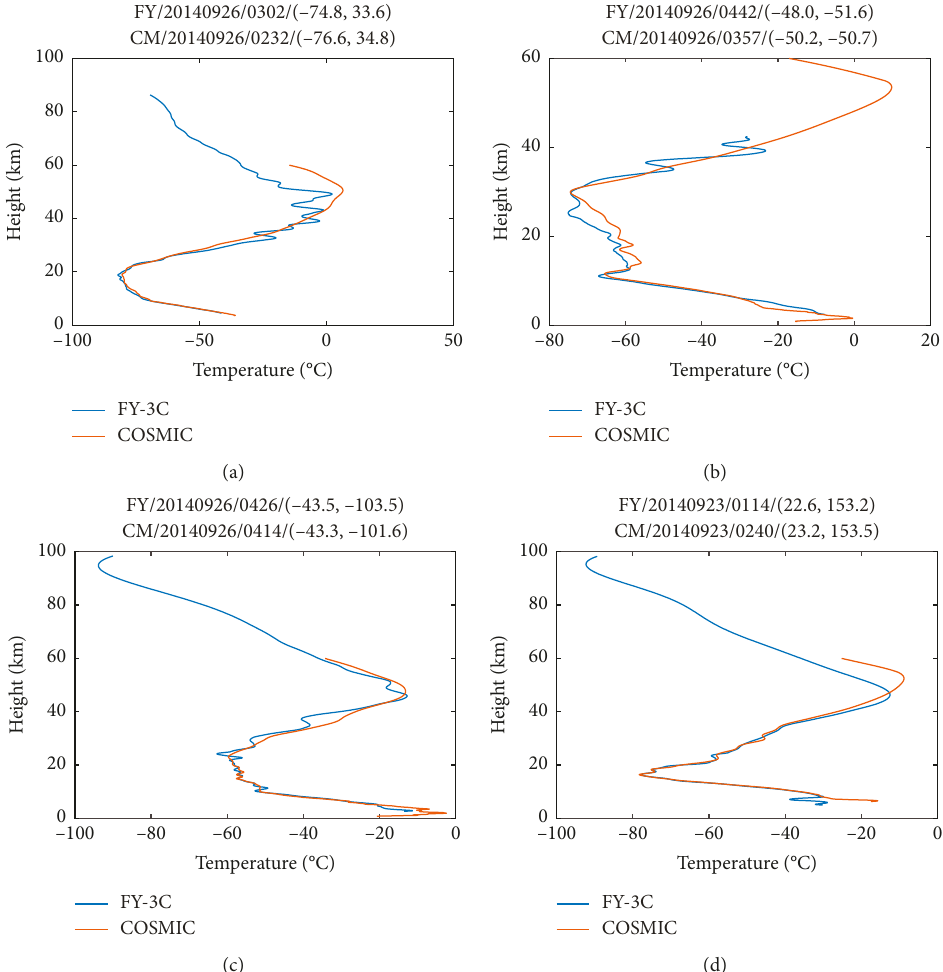
Figure 6: Comparison of the temperature profiles obtained from FY-3C and COSMIC occultation data.